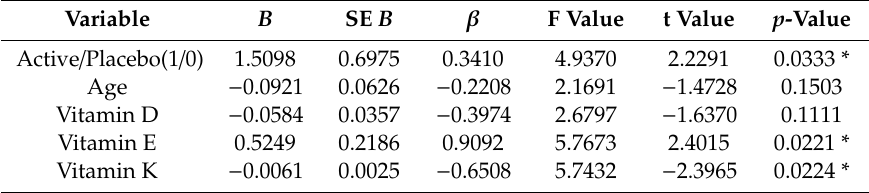
Table 7. Multiple Regression Analysis of the change in MoCA score and the number of fat-soluble vitamins. Variable B SE B β F Value t Value p -Value Active / Placebo(1 / 0) 1.5098 0.6975 0.3410